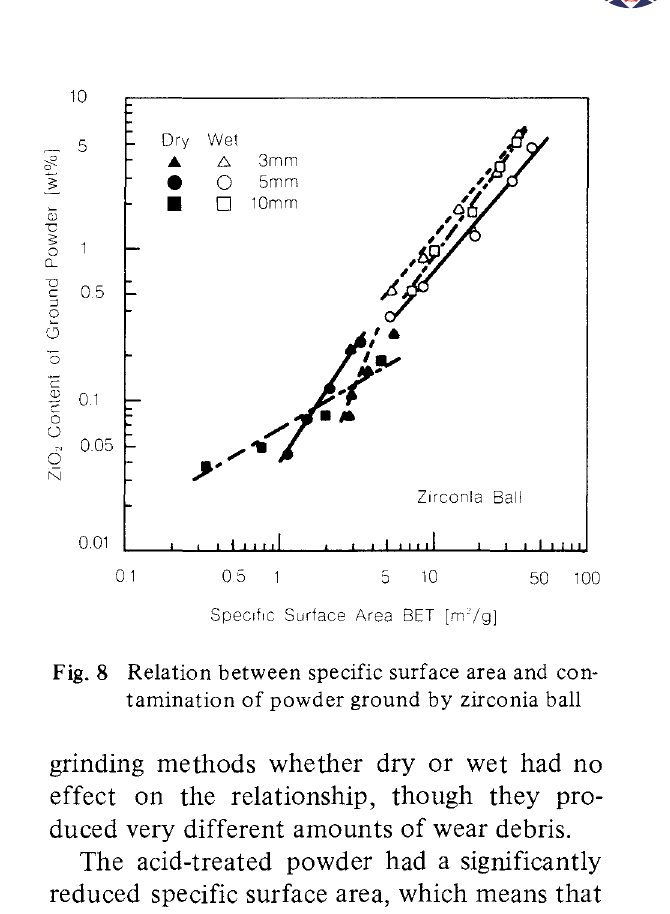
Fig. 8 Relation between specific surface area and